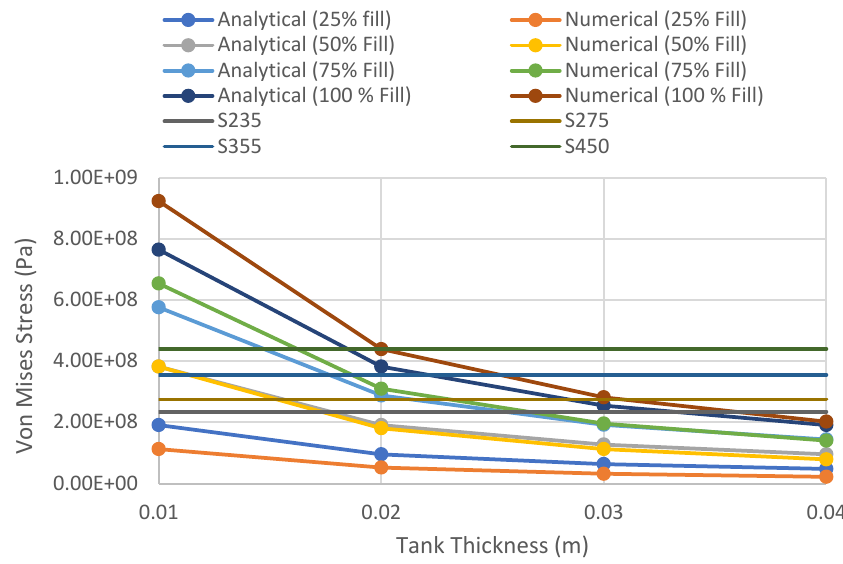
Figure 5. Variation of Von Mises stress versus fill level of different tank thicknesses.